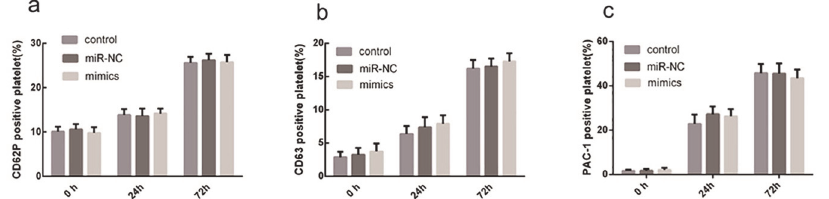
Fig 6. Platelets are not activated by miR-326 expression. Leukocyte-depleted apheresis platelets (LDPs) were untransfected (control) or treated with 50 nM miR-326 mimic or non-targeting negative control (miR-NC). LDPs were cultured under standard blood banking conditions and harvested at the indicated times. Expression and activity was determined by flow cytometry. ( a ) Relative number of P-selectin (CD62p)- positive platelets. ( b ) Relative number of CD63-positive platelets. ( c ) Relative number of PAC-1-positive platelets. Data were quantified from 3 separate experiments and are shown as mean ± SD.